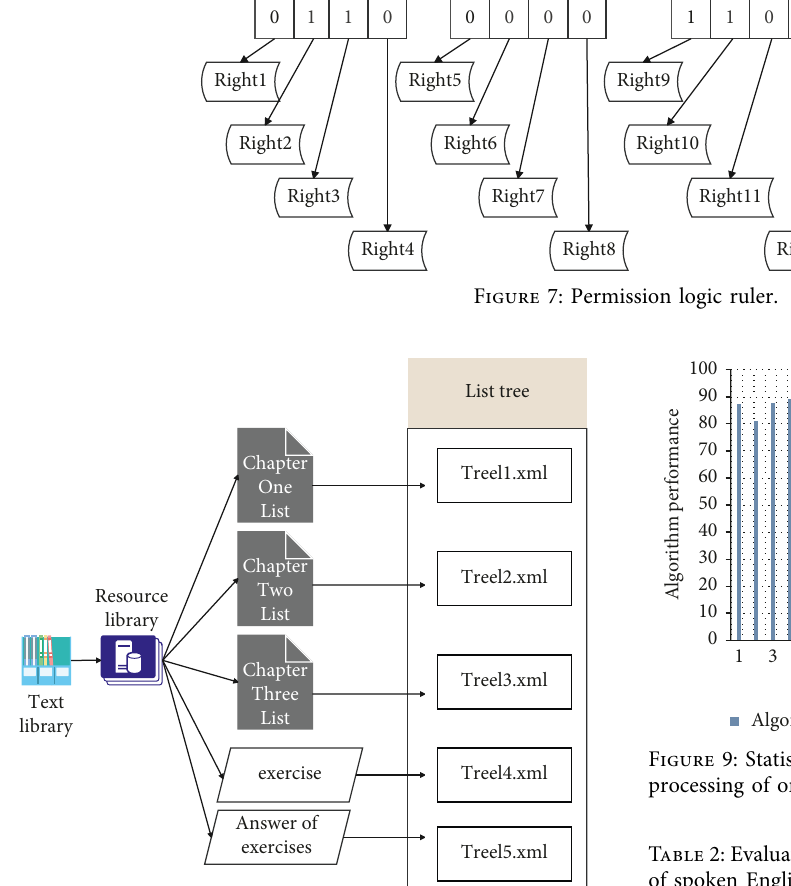
Figure 8: The structure diagram of the classification directory of online teaching resources for custom spoken English. Table 1: The effect of deep learning in the processing of online teaching resources of spoken English.